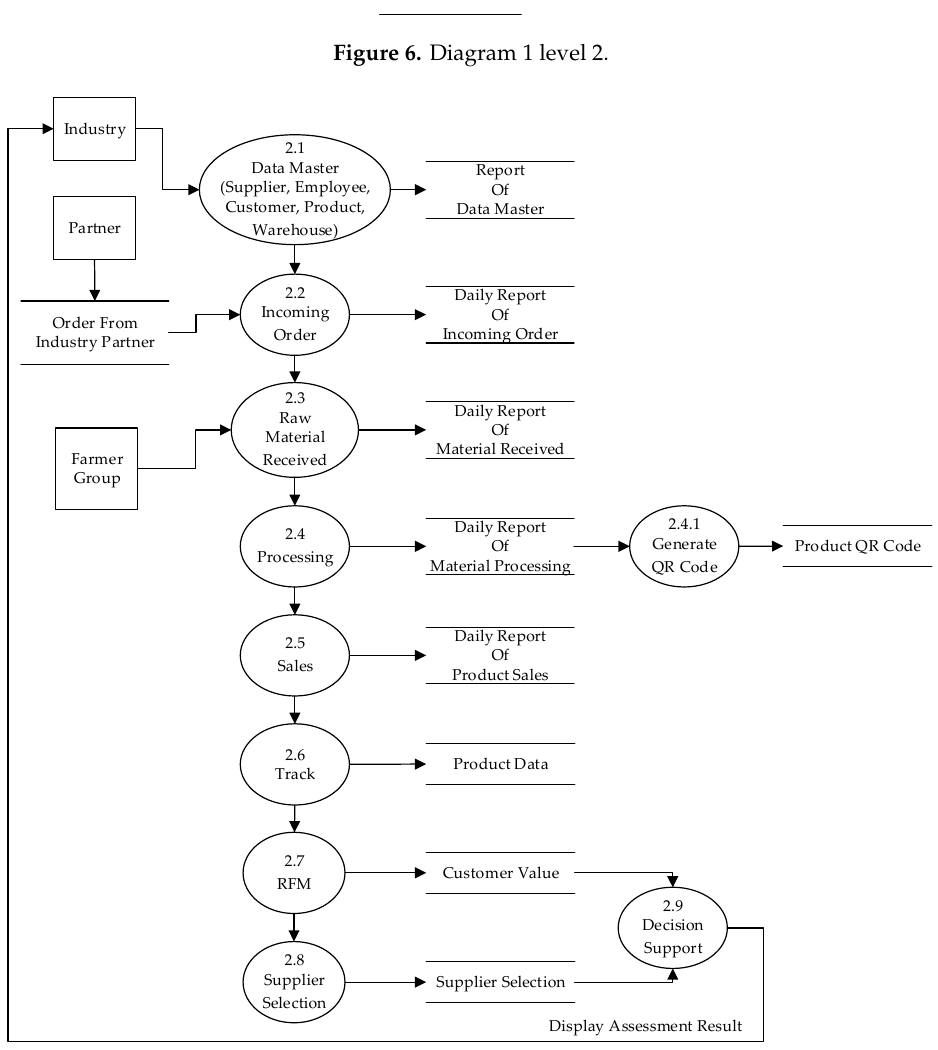
Figure 7. Diagram 2 level 2.